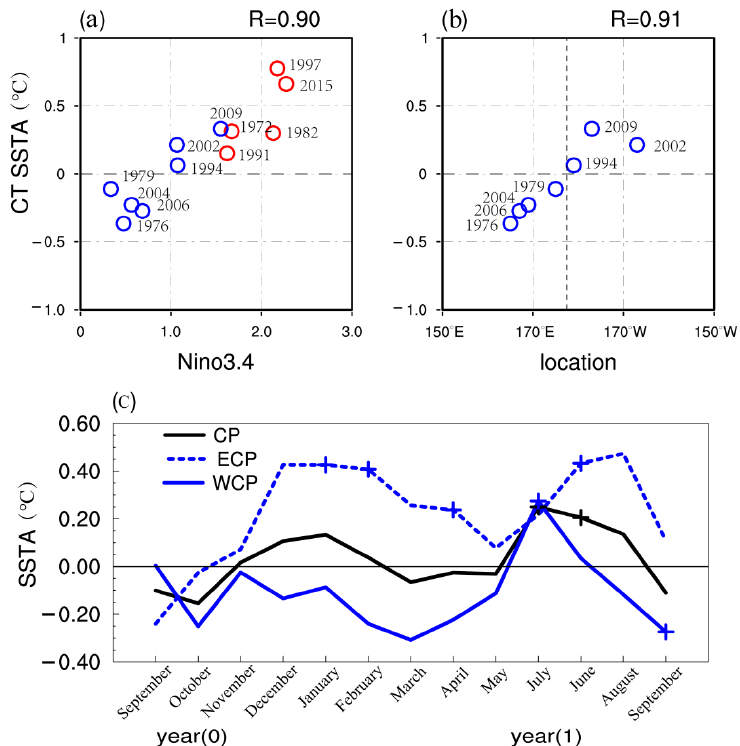
Figure 3. Scatter plots of DJF CT SSTA (°C, 110–118° E, 10–13° N averaged) with ( a ) DJF Niño3.4 index, ( b ) the position of CP El Niño’s warm SSTA, which is defined as the maximum zonal gradient. In ( a , b ), the red (blue) circles represent EP (CP) El Niño events. ( c ) Time series of averaged SSTA (°C) over the CT region (110–118° E, 10–13° N averaged) in ECP (dash blue line), WCP (solid blue line) and CP El Niño events (black line). “+” symbols in ( c ) indicate values exceeding the 90% confidence level. Zhang et al. [17,27] demonstrated that the atmospheric response over the Indian Ocean and East Asia is highly sensitive to the SSTA zonal location of CP El Niño. A consistent effect is observed in terms of the CT SST response in this study. Here, the zonal location of the CP El Niño is defined as the maximum zonal gradient of the CP El Niño warm SSTA (5° S–5° N mean). Therefore, according to Figure 3b, when the CP El Niño is located east of 175° E, a positive SSTA would be formed in the CT region. In sharp contrast, a cooling SSTA would be observed if the warming SSTA of the CP El Niño lies west of 175° E. Their correlation coefficient is up to 0.91, reaching a 95% confidence level. There- fore, the CP El Niño events are naturally divided into two sub-groups: east CP El Niño events (ECP), with the warm SSTA located east of 175° E, including the events of 1994, 2002 and 2009; and west CP El Niño events (WCP), with the warm SSTA located west of 175° E, including the events in 1976, 1979, 2004 and 2006. As a consequence, the response of CT SSTA mainly depends on the location of the warm SSTA center of CP El Niño (Figure 3c). For ECP El Niño events—that is, the warm SSTA of CP El Niño is located relatively eastward—the corresponding SSTA over the CT region exhibits a similar and comparable evolution with that of EP El Niño events. A robust warm SSTA with an intensity greater than 0.4 ◦ C occurs during both the winter and the following summer. However, the CT SSTA of WCP El Niño events is below normal all the time during the developing and decaying period of El Niño, except in June, when it is rather weaker than that of ECP El Niño events. Without doubt, the expected first warm peak in winter does not happen, while the second peak only